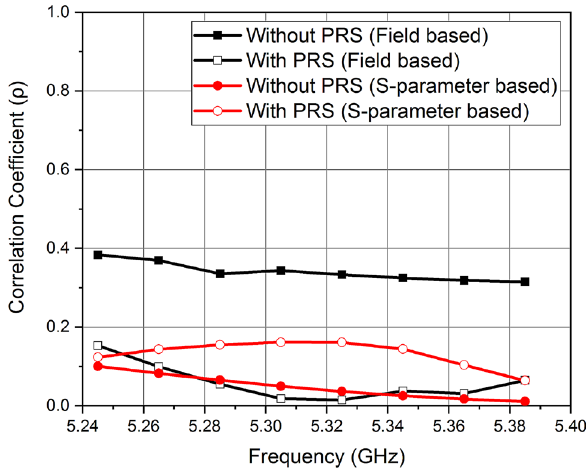
Figure 7. Calculated ρ Value using field-based equation and S-parameter-based equation.